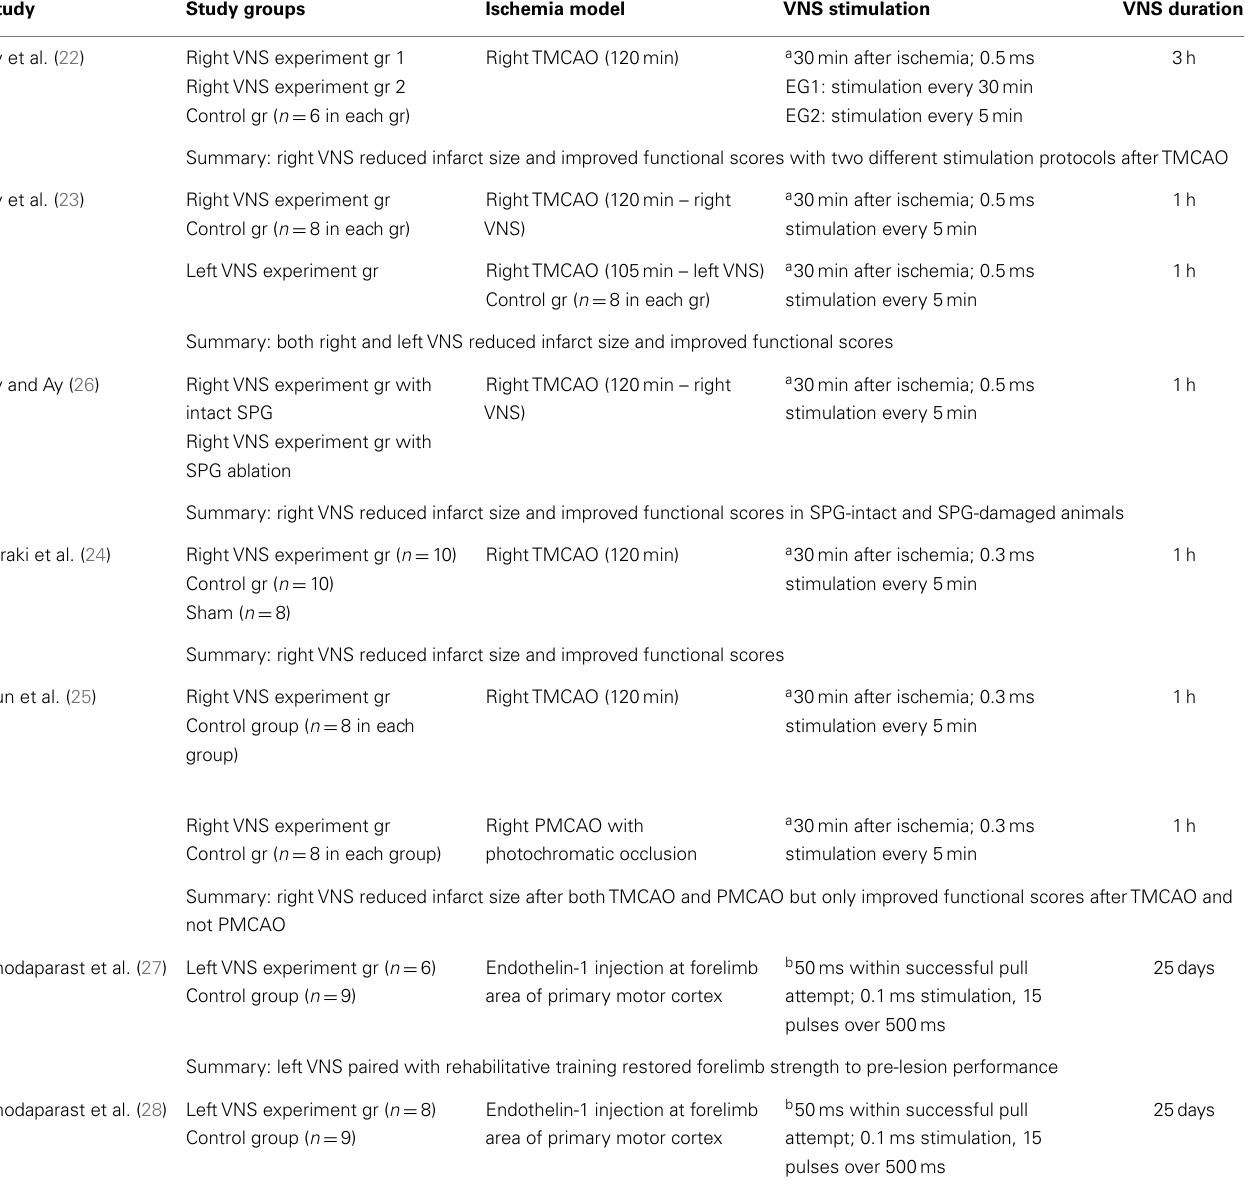
Summary: left VNS paired with rehabilitative training restored forelimb function to pre-lesion performance MCAO, middle cerebral artery occlusion;VNS, vagus nerve stimulation; gr, group;TMCAO, temporary middle cerebral artery occlusion; PMCAO, permanent middle cerebral artery occlusion; SPG, sphenopalatine ganglion. a Groups used 0.5mA and 20Hz pulse